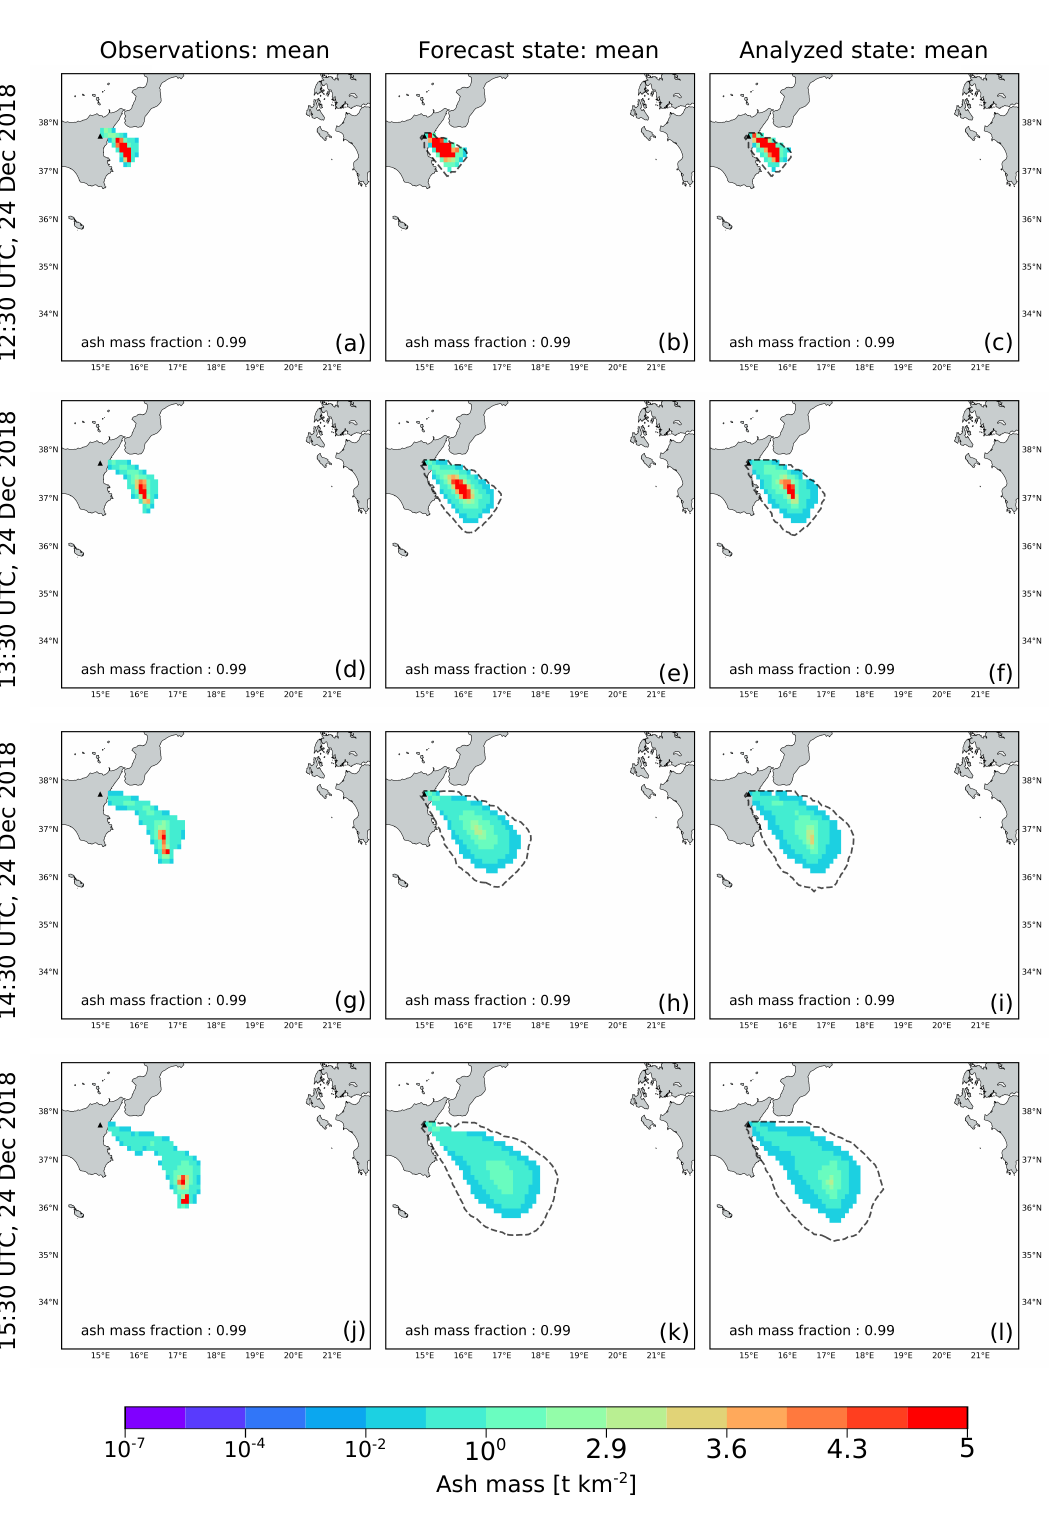
Figure 5. Mean states resulting from EXP1. Panels ( a , d , g , j ) show the ash cloud as detected from space (Observations). Panels ( b , e , h , k ) illustrate the ash cloud as predicted by the numerical model PLUME-MoM&HYSPLIT (Forecast state), while Panels ( c , f , i , l ) present the results of the assimilation cycles (Analyzed state). A cut-off of 0.01 t km − 2 was applied to original ash column density. The edges of the original ash cloud (both forecast and analyzed) are indicated by the black dotted lines. In this figure are displayed the assimilation cycles performed at 12:30, 13:30, 14:30 and